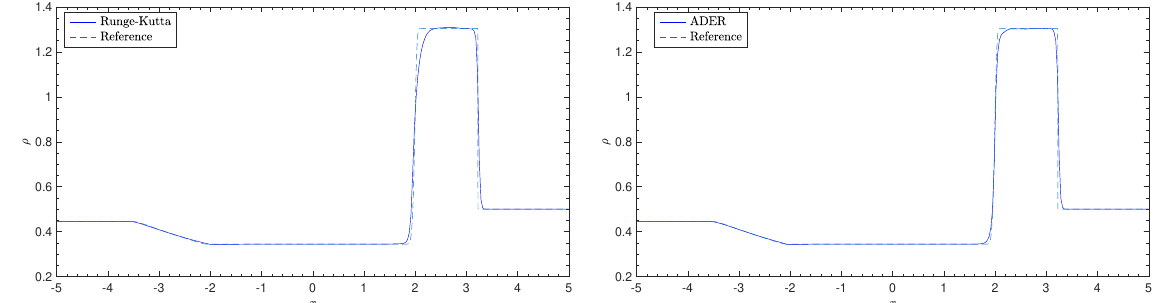
Figure 11. Computed density variable ρ for the problem (64) (Euler equations) with the fourth-order well-balanced Runge–Kutta ( left ) and ADER ( right ) numerical methods at time t = 1.3 s. An uniform Cartesian mesh of N x = 300 elements has been